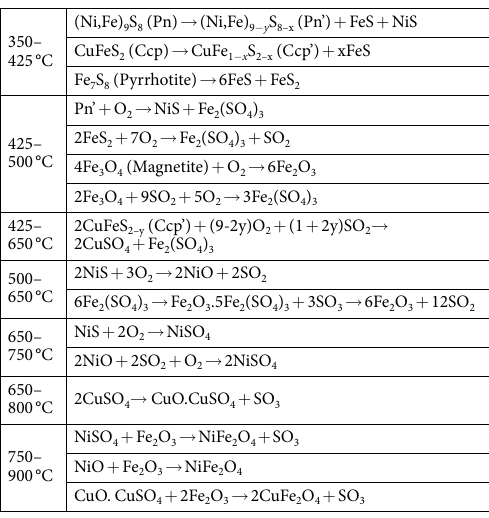
Table 1. Summary of the reaction sequence that occurred during the oxidative roasting of Ni–Cu sulphide in air.